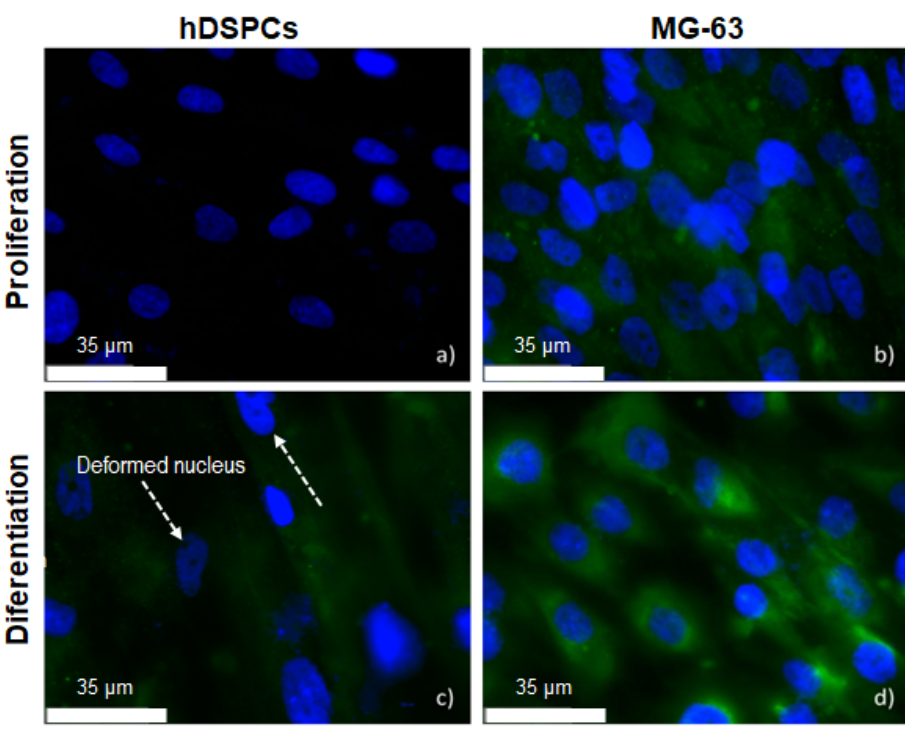
Figure 11. Immunocytochemical staining with osteocalcin (OC) and counterstained with DAPI in the hDPSCs and MG-63 cells cultured in conventional medium (first line) and differentiation medium (second line) on flat surfaces (2D). ( a ) Immunocytochemical staining of hDPSCs in conventional culture medium. ( b ) Immunocytochemical staining of MG-63 in conventional culture medium. ( c ) Immunocytochemical staining of hDPSCs in differentiation culture medium. ( d ) Immunocytochemical staining of MG-63 in differentiation culture medium.